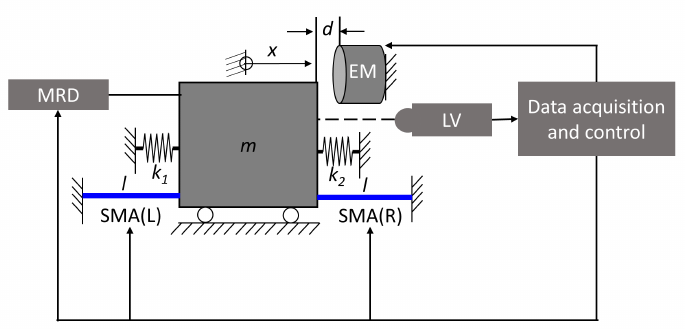
Figure 3. Schematic of SMA-MR damper system test setup with vibrational system ( k , m ) . Legend: